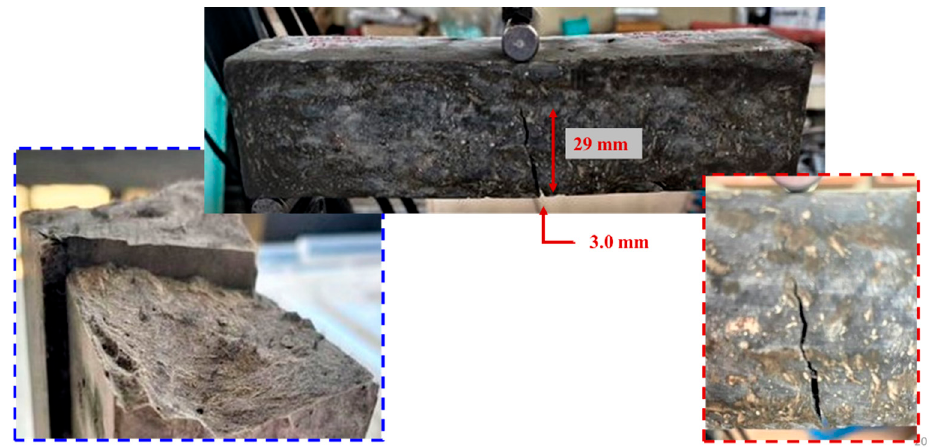
Figure 11. Crack width and length after three-point bending test and CFs concentration at the rup- ture interface in the case of simple manually wet manually mixing of CFs and SP addition.